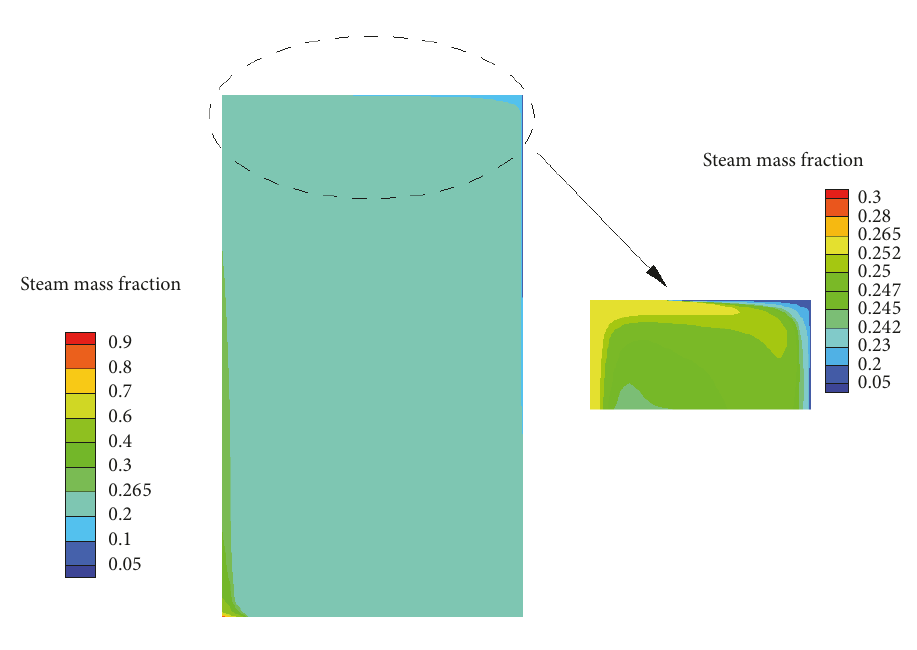
Figure 7: Steam mass fraction in the scaled AP600 containment.